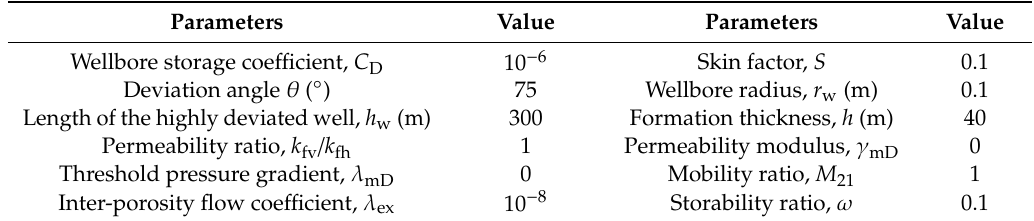
Table 1. Formation, fluid and wellbore parameters for verification.